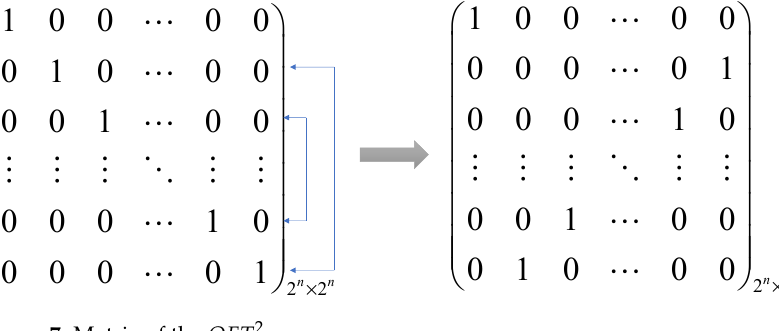
Figure 6. A circuit forthe QFT 2 . Figure 6. A c ircuit forthe 2 QFT . For a 2 n × 2 n dimensional identity matrix, we can obtain the QFT 2 by row transforma- For a 2 2 n n × dimensional identity matrix, we can obtain the 2 QFT by row transfor- tion, as shown in Figure 7. mation, as shown in Figure 7.